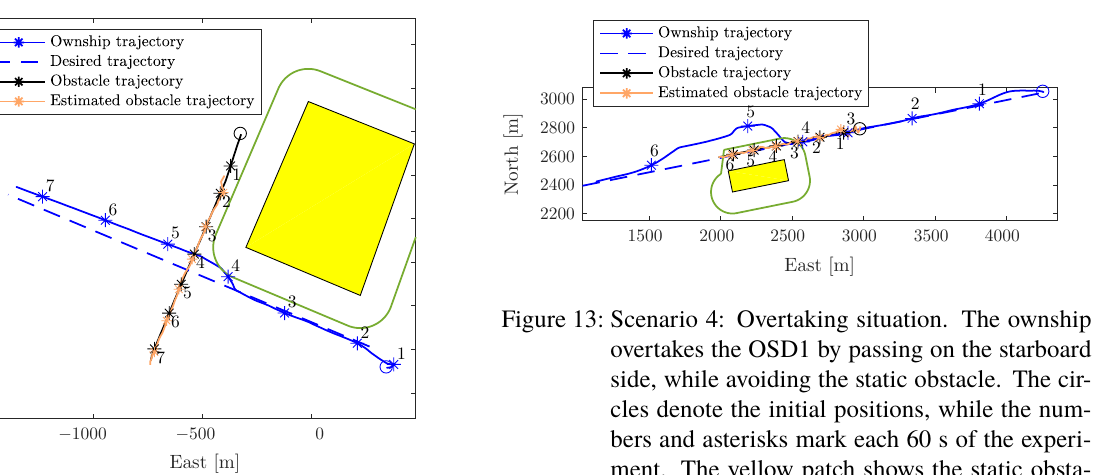
Figure 12: Scenario 3: Crossing situation. The desired trajectory intersects with the OSD1, which ap- proaches from starboard. The static obstacle encloses Munkholmen, which is a small island located in the Trondheimsfjord. The circles de- note the initial positions, while the numbers and asterisks mark each 60 s of the experiment. The yellow patch shows the static obstacle, while the dark green contour line shows the padding region.